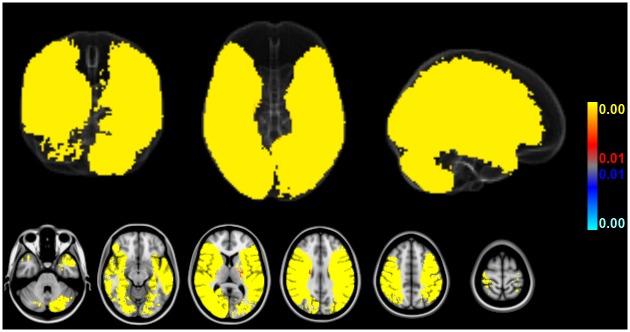
Association of stroke size and voxelwise ischemic involvement across 582 patients.Larger strokes were associated with more frequent ischemic lesions in the MCA territory of both hemispheres and parts of the posterior circulation while smaller strokes were not associated with more frequent ischemic insults of any brain area. (Red-to-yellow: areas significantly associated with higher crIV, blue-to-lightblue: areas significantly associated with lower crIV across all n = 582 patients; thresholded at FDR-corrected q = 0.01; age and gender included as covariates of no interest, AF status unmodeled).